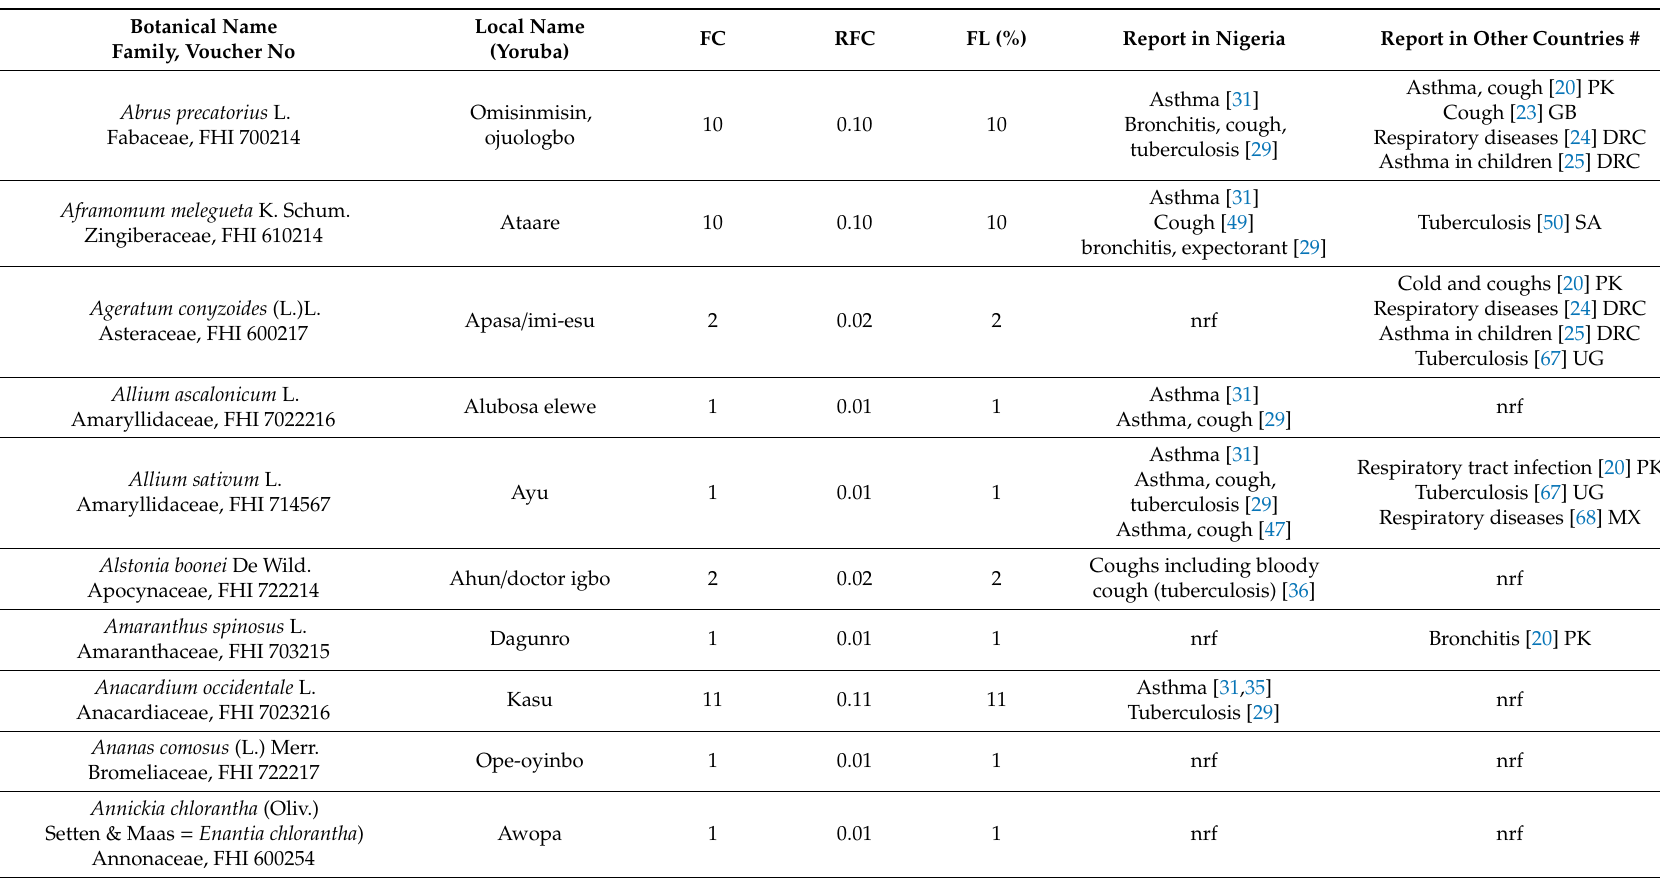
Table 2. Ethnobotanical indices (frequency of citation; FC, relative frequency of citation; RFC and fidelity level; FL) of plant species used for treating cough associated with respiratory diseases in Ede South Local Government Area of Osun State, Nigeria. (Fabaceae =